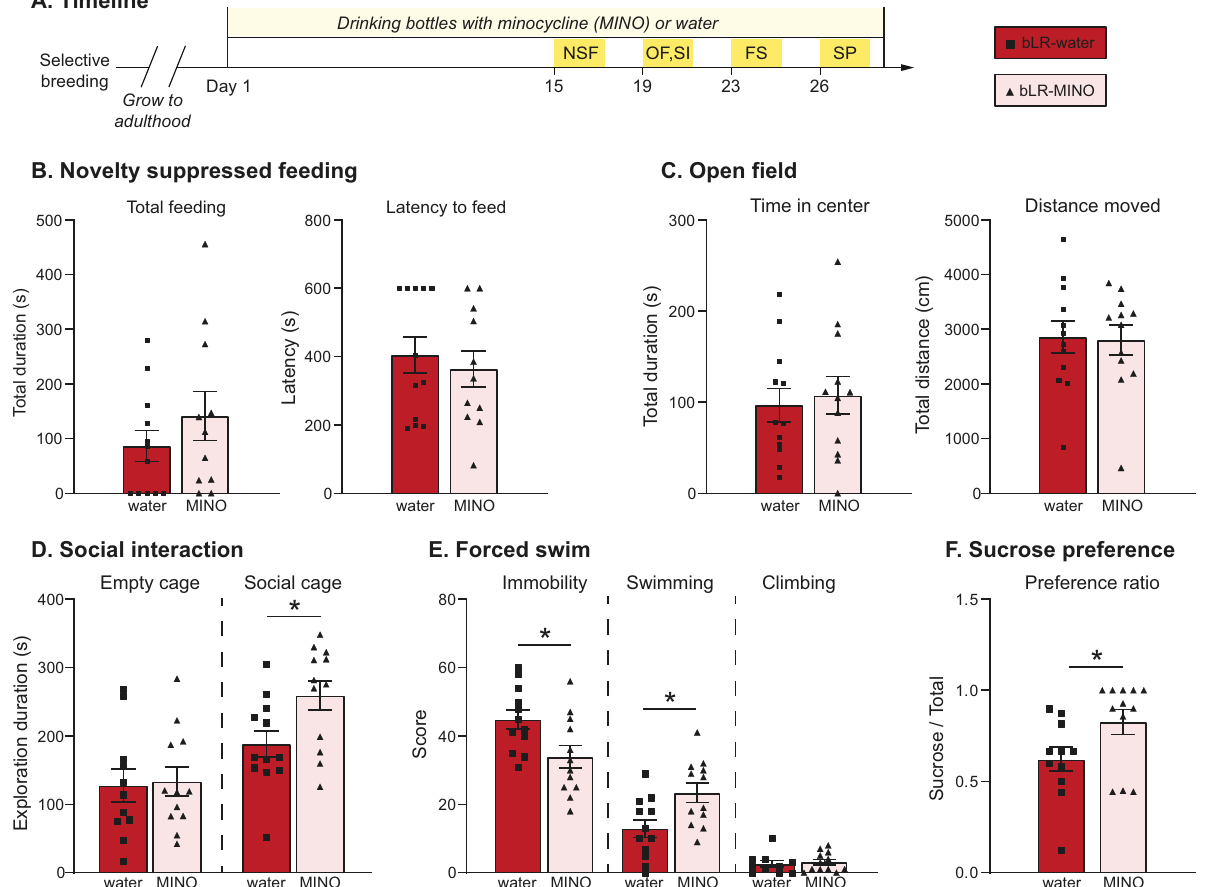
Fig. 3 Minocycline shifts multiple aspects of bLR phenotype. A separate cohort of bLRs was given an extended testing sequence following minocycline administration. A Schematic of administration and testing timeline, Day 1 = fi rst day of minocycline. Minocycline did not affect bLR anxiety measured by novelty suppressed feeding ( B ) or open fi eld ( C ) (all p > 0.05). In the social preference test ( D ), minocycline-treated bLRs spent more time exploring the cage containing the social stimulus compared to control bLRs (* t 22 = 2.454, p = 0.023). E In the Forced Swim challenge, minocycline decreased immobility scores (* t 22 = 2.754, p = 0.012), specially through an increase in swimming behavior (* t 22 = 2.775, p = 0.011). F Minocycline also increased sucrose preference (* t 22 = 2.155, p = 0.042). Data are expressed as mean ± SEM, with scatter plots overlaid to show individual data points. Abbreviations: FS forced swim; NSF novelty suppressed feeding; OF open fi eld; SI social interaction; SP sucrose